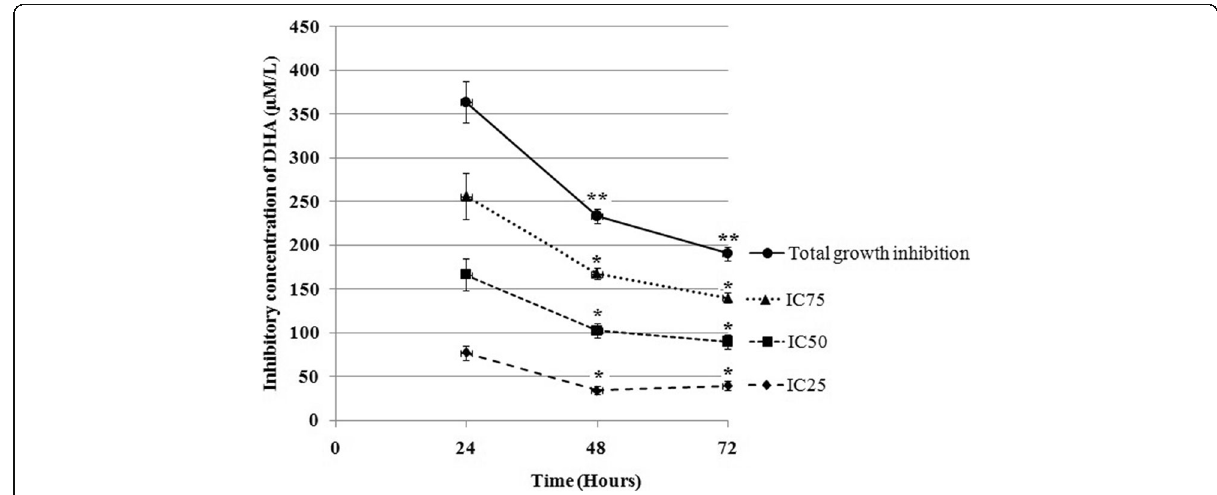
Fig. 2 Total growth inhibition and IC 25, 50, 75 values in DHA-treated cells. 5 × 10 3 HCT-116 cells per well were treated with DHA at concentrations 0, 100, 150, and 200 μ M from 24 to 72 h, after which IC 25, 50, 75 and total growth-inhibition values were calculated from the dose-response curves. The results represent mean ± SD of two independent experiments with triplicate assays. The results obtained from 48- and 72-h treatments were compared with 24-h treatment results in each of inhibitory concentration (IC) of DHA. * P < 0.05 and ** P <